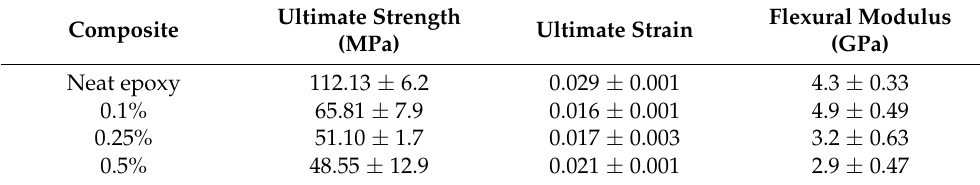
Figure 6. Stress–strain curves for epoxy-ZnO composites before irradiation. Table 4. Flexural properties of epoxy-ZnO composites before irradiation.